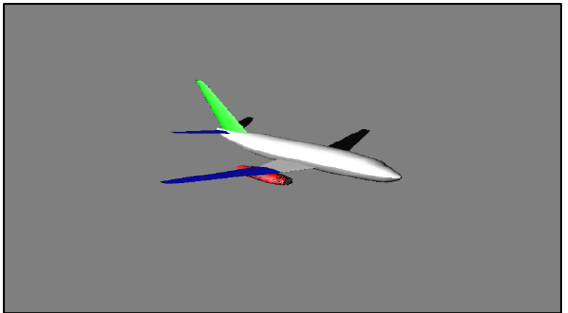
Figure 3. Boeing 737 model, as prepared using US DATCOM in this